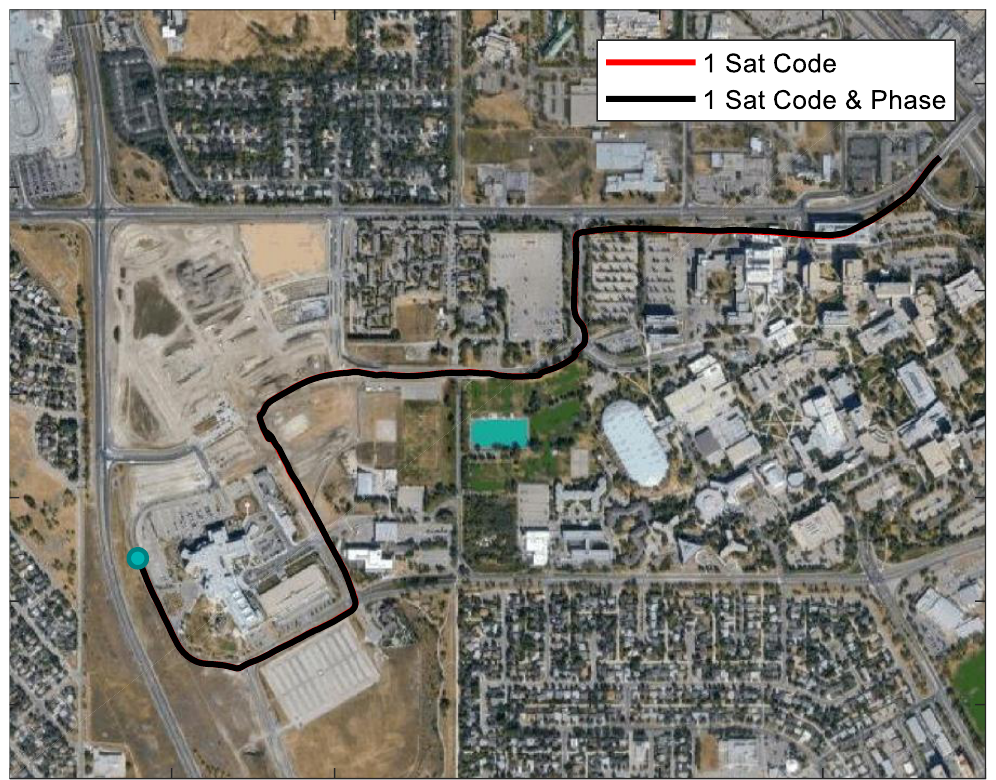
Figure 5. Trajectories of using G32.